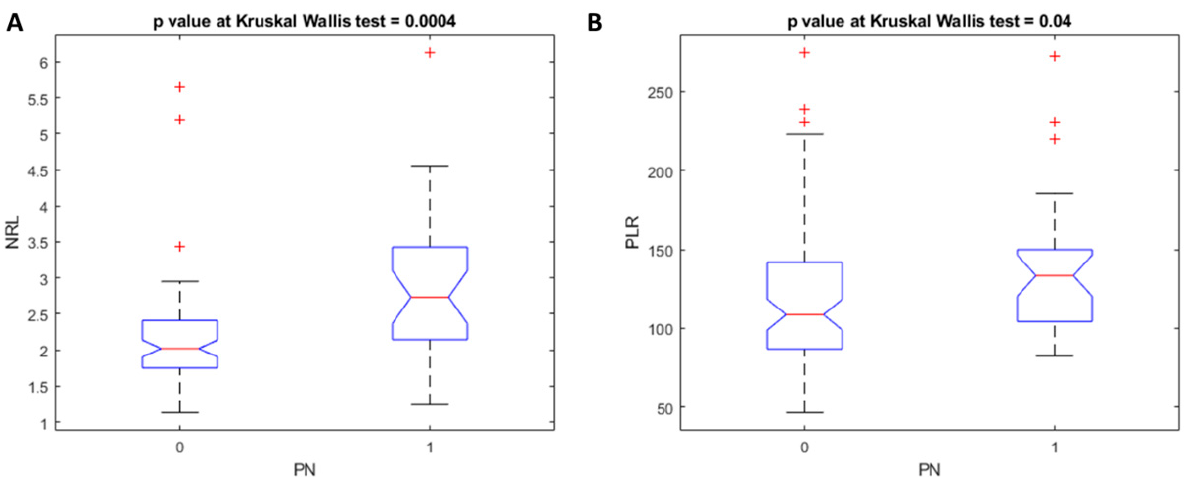
Figure 1. Boxplot of the NLR ( A ) and PLR ( B ).